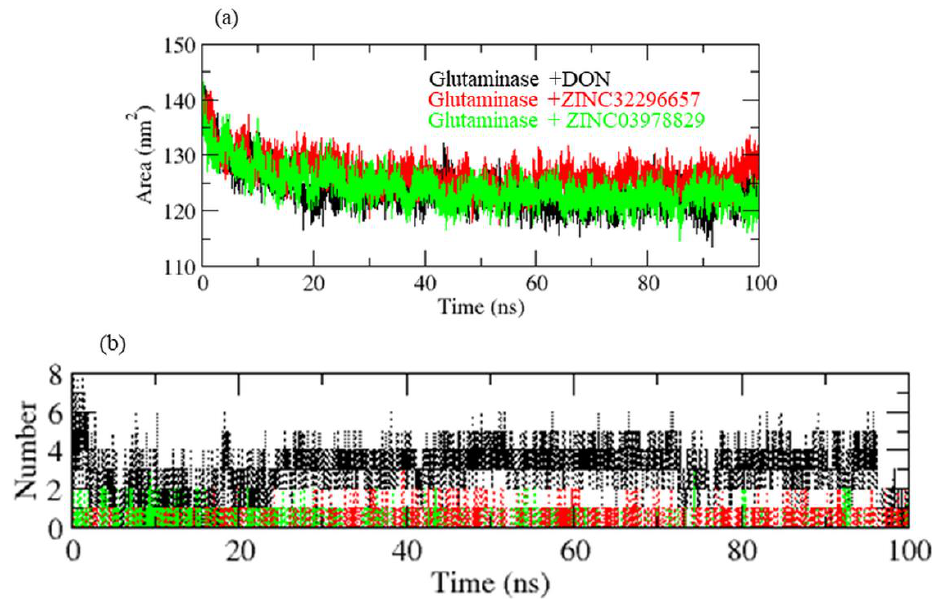
Figure 5. ( a ) SASA of GLS enzyme, ( b ) hydrogen bonding pattern of complexes. The hydrogen bond is vital in the stability of the ligand–target complex [33]. Between protein and ligand, hydrogen bonds were formed within 0.35 nm. The stability of docked complexes was tested using 100 ns simulations of GLS-DON (control), GLS-ZINC32296657, and GLS-ZINC03978829 in a solvent environment. GLS-DON and GLS-ZINC03978829 form 2–5 hydrogen bonds with the GLS catalytic pocket, whereas GLS-ZINC32296657 forms 1–2 hydrogen bonds with the GLS catalytic pocket. GLS-ZINC32296657 formed fewer H-bonds due to instability in the pocket of the GLS enzyme (Figure 5b). The energy landscape of the complexes GLS-ZINC32296657, GLS-ZINC03978829, and GLS-DON has been plotted. The blue color denotes the location with the least amount of energy. The GLS-ZINC03978829 complex has two distinct global energy minima basins (in blue), whereas the GLS-DON and GLS-ZINC32296657 complexes have comparable energy minima states. The blue spots represent greater stability, whereas more blue areas represent shifts in the protein structure followed by the thermodynamically more favorable state (Figure